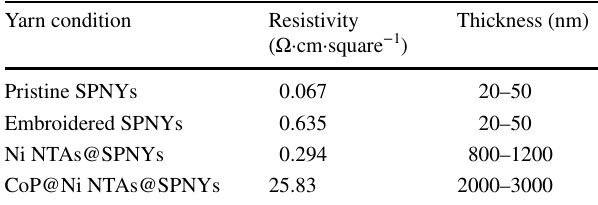
Table 1 Electrical resistances of different SPNYs Yarn